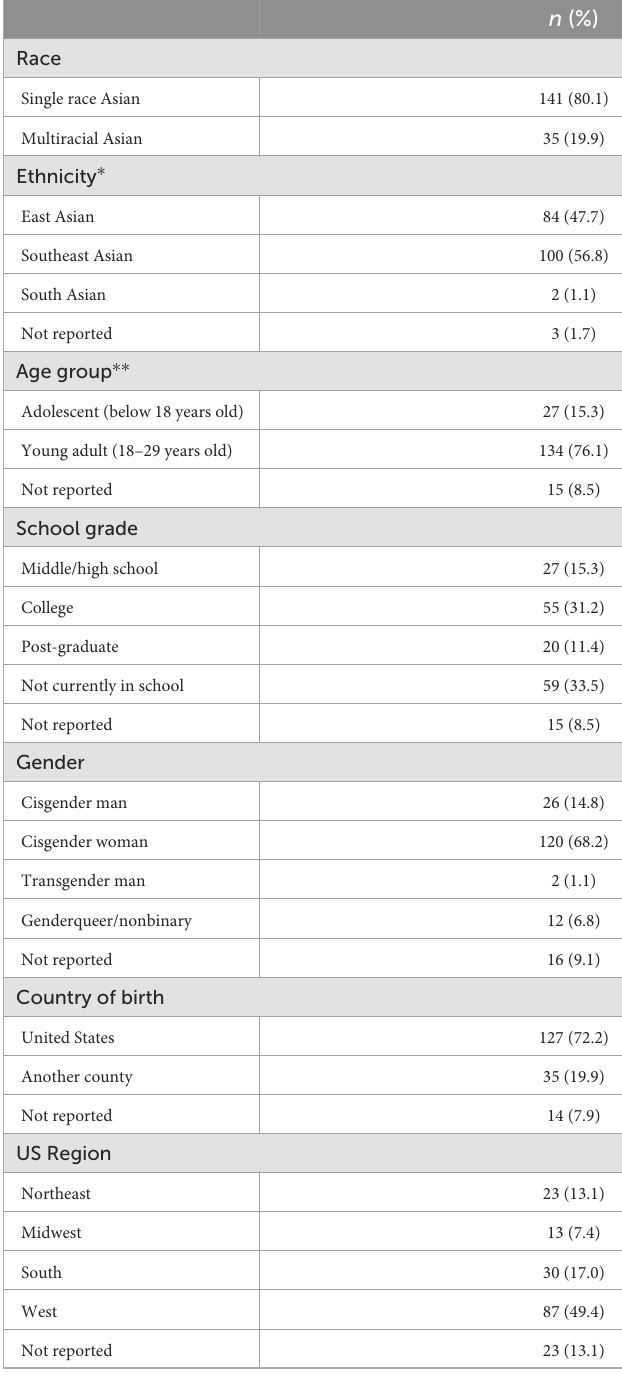
TABLE 1 Distribution of sociodemographic characteristics among YAAHS respondents ( N =